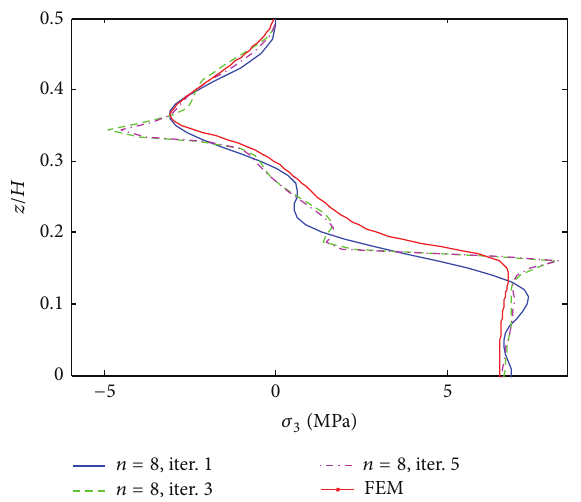
Figure 3: 𝜎 3 distribution of [PZT/0 4 /90 4 ]s laminate at the free edge from different iterations, under 0.1% uniaxial strain.